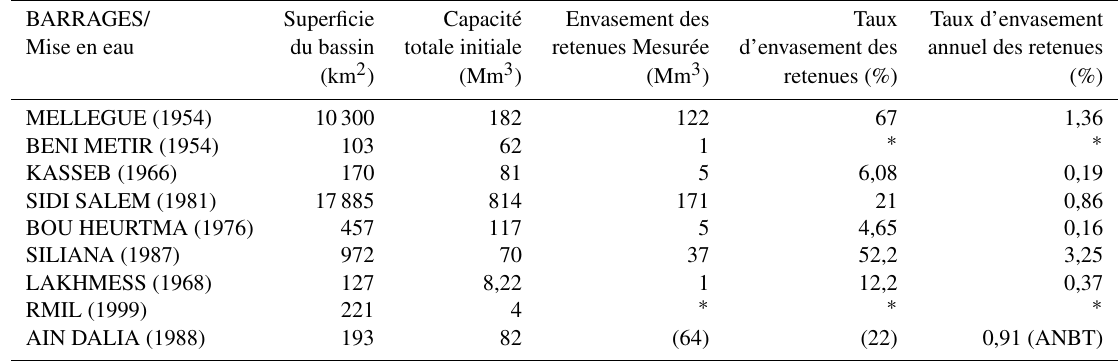
Tableau 1. Caractéristiques des aménagements construits sur le bassin versant de la Medjerda (DGBGTH, 2016). BARRAGES/ Superficie Capacité Envasement des Taux Taux d’envasement Mise en eau du bassin totale initiale retenues Mesurée d’envasement des annuel des retenues (km 2 ) (Mm 3 ) (Mm 3 ) retenues (%) (%) 10300